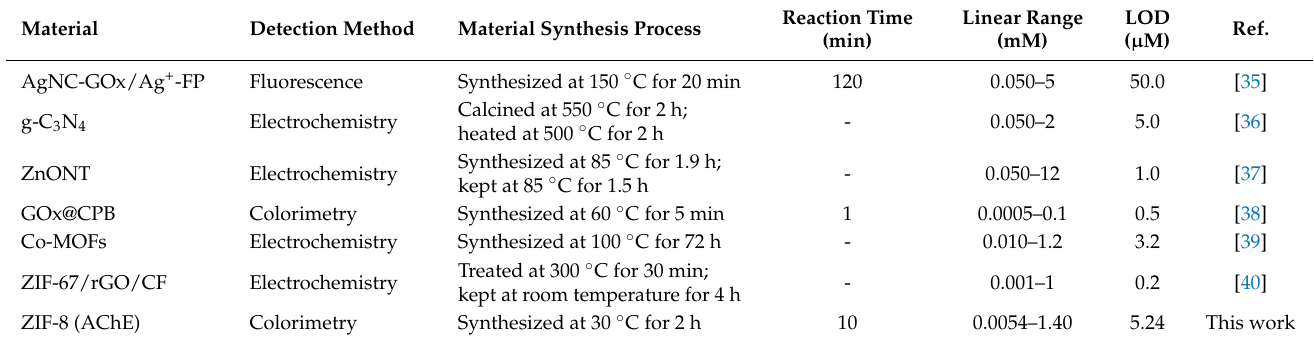
Table 3. Comparison of the previously reported methods and present work for the detection of glucose.